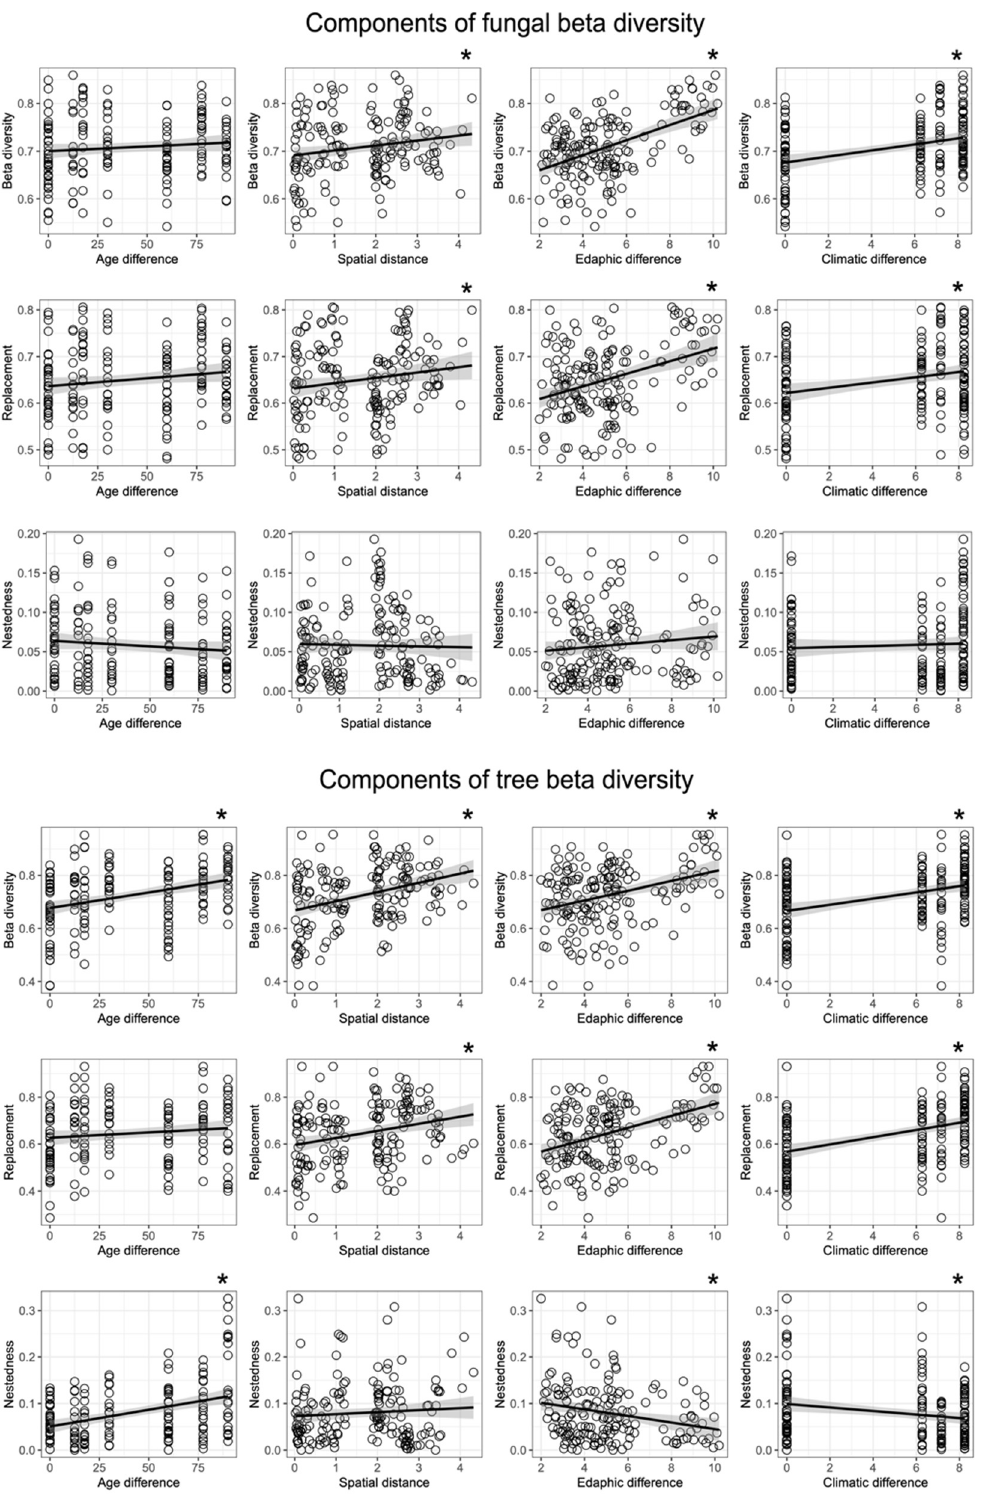
Figure 6. Correlation of total β -diversity and its replacement and nestedness components fungal and tree communities with pairwise differences in environmental factors among the sites. Significant correlations are indicated by asterisk